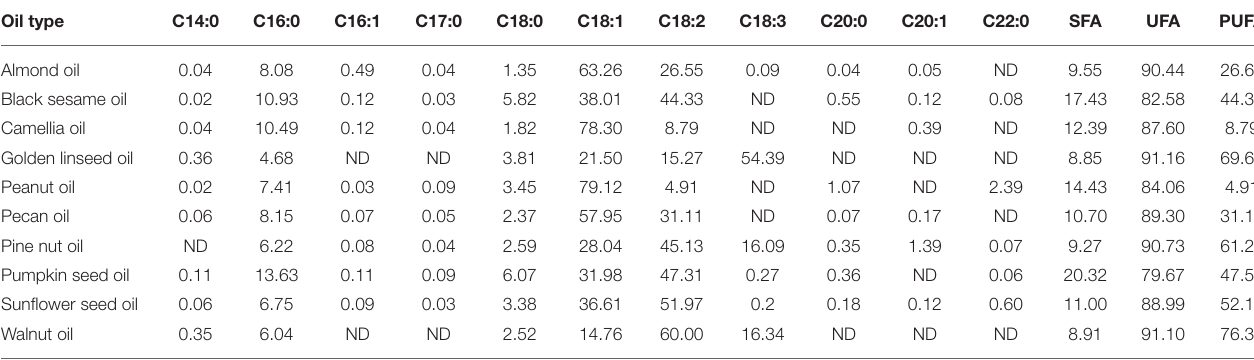
TABLE 1 | Fatty acid compositions of 10 expeller-pressed oils. Oil type